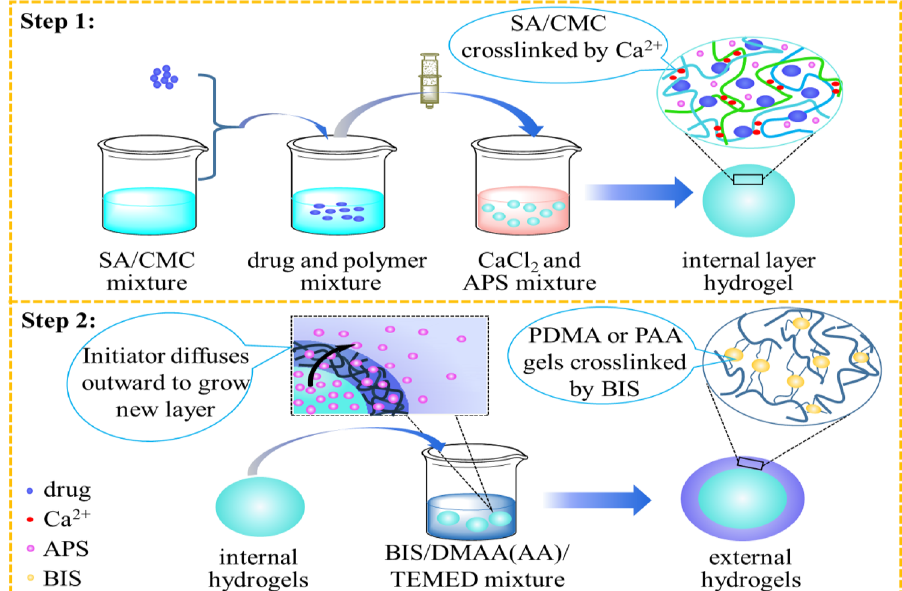
Figure 13. Preparation schematic diagram of double-layer